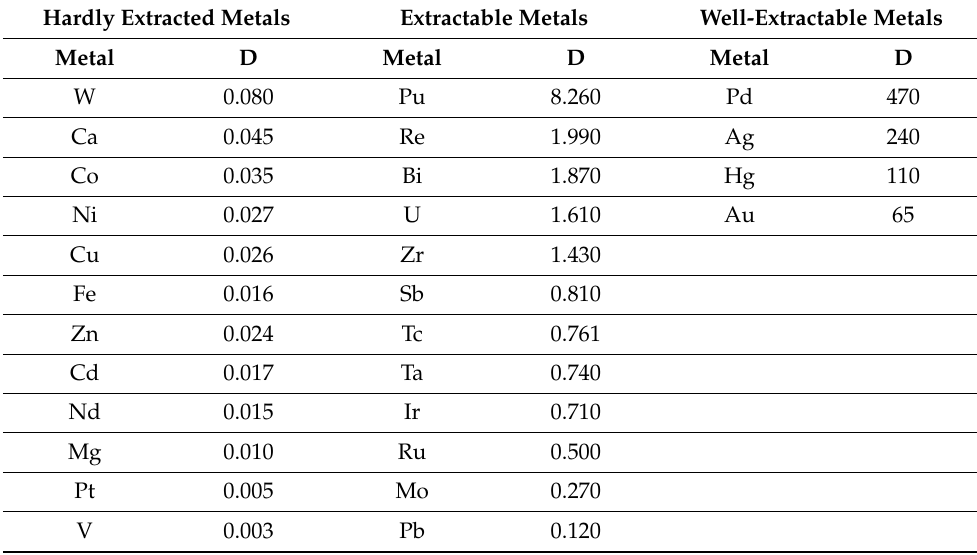
Table 3. Distribution ratio values obtained by extraction with compound 29 in n -dodecane (condi-